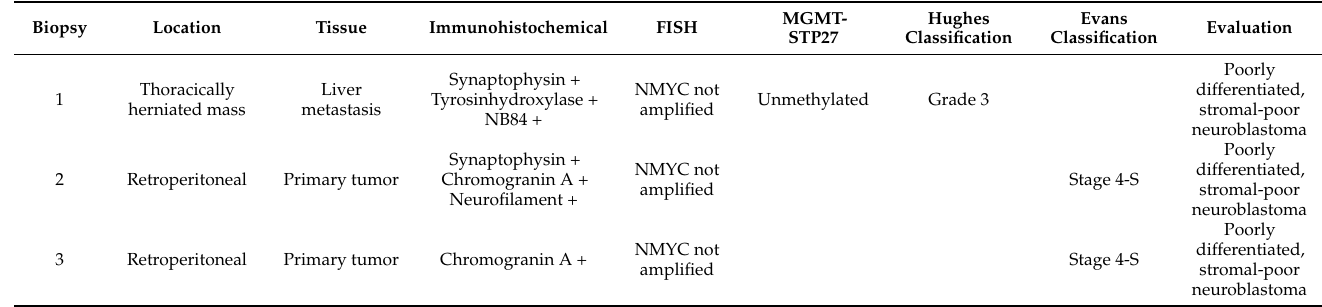
Table 1. Analysis of the biopsies. The results of all biopsies led to the diagnosis of a favorable stage IV-S neuroblastoma.